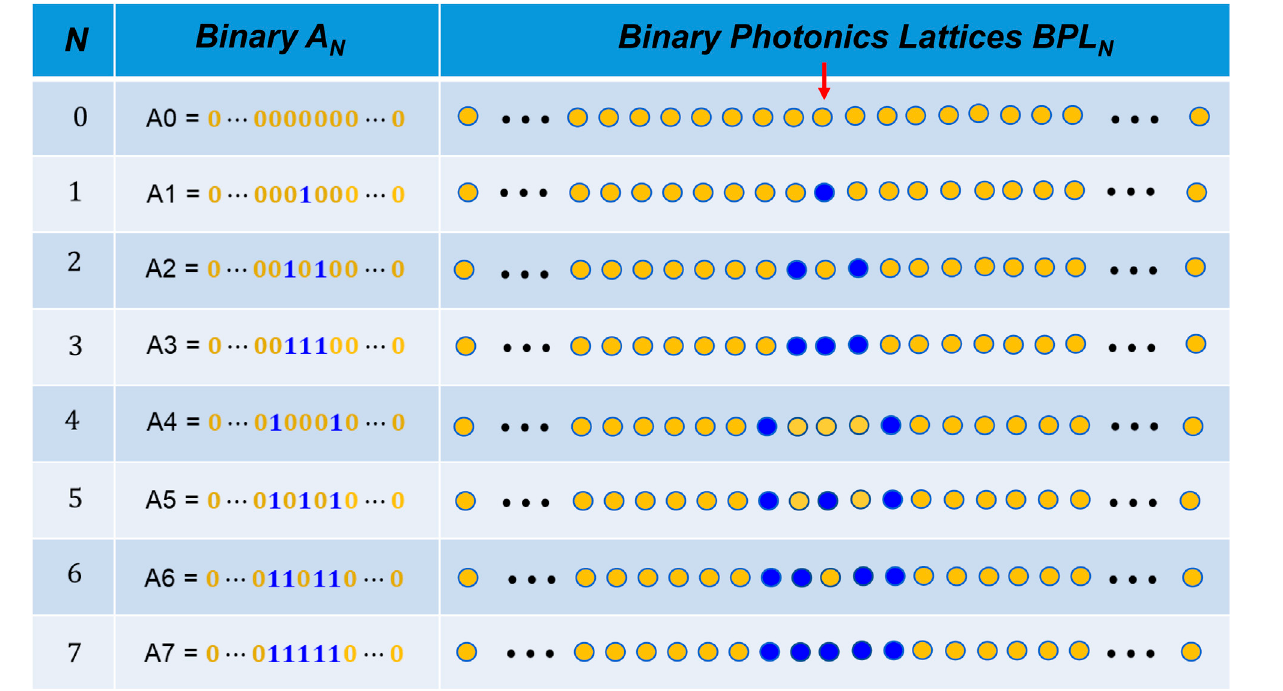
TABLE1| Binaryphotonicslattices BPL N (3rdcolumn)canbeusedtorepresenttheGBRorbinary A N (2 nd column)thatisthebinaryrepresentationofthedecimalnumber N (1 st column). Light con fi nement in SM waveguide A is stronger than in WG B , representing digits “ 1 ” and “ 0 ” of the binaries, respectively.